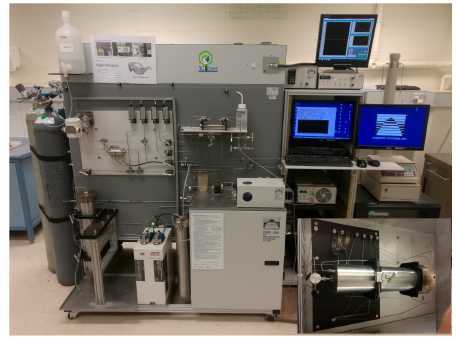
Figure 2. Core flooding set-up for permeability